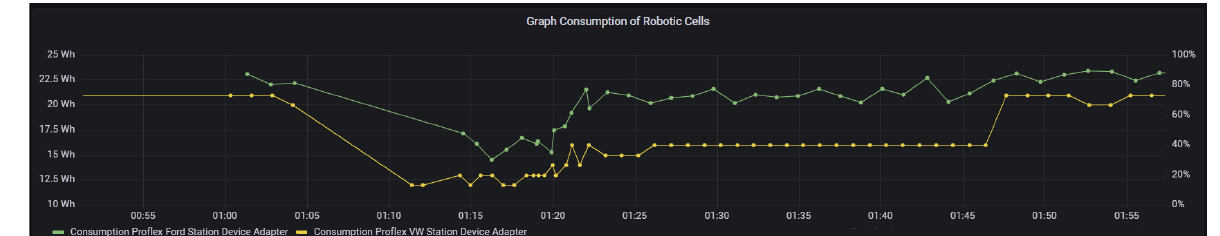
Figure 22. Time graph of each robotic cell energy consumption.